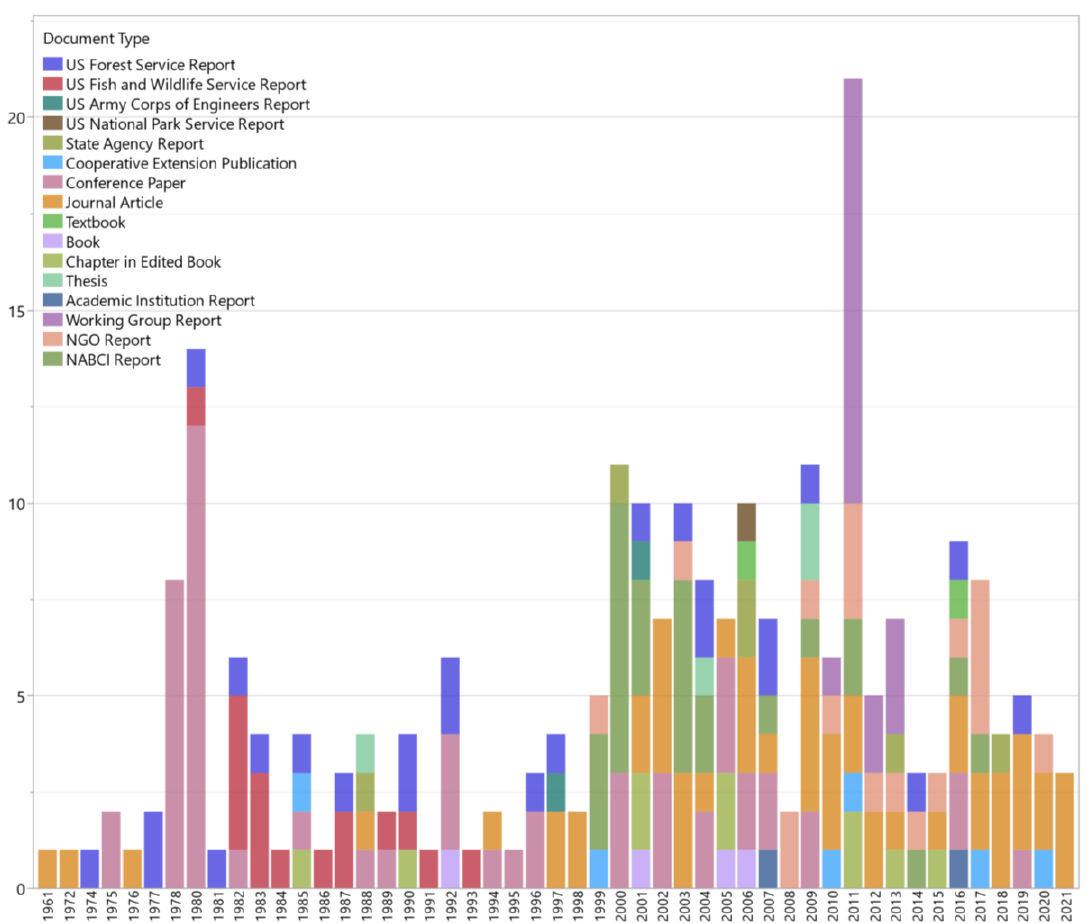
Figure 11. Temporal patterns in document types selected for inclusion in Supplementary S5 and/or Supplementary S6.